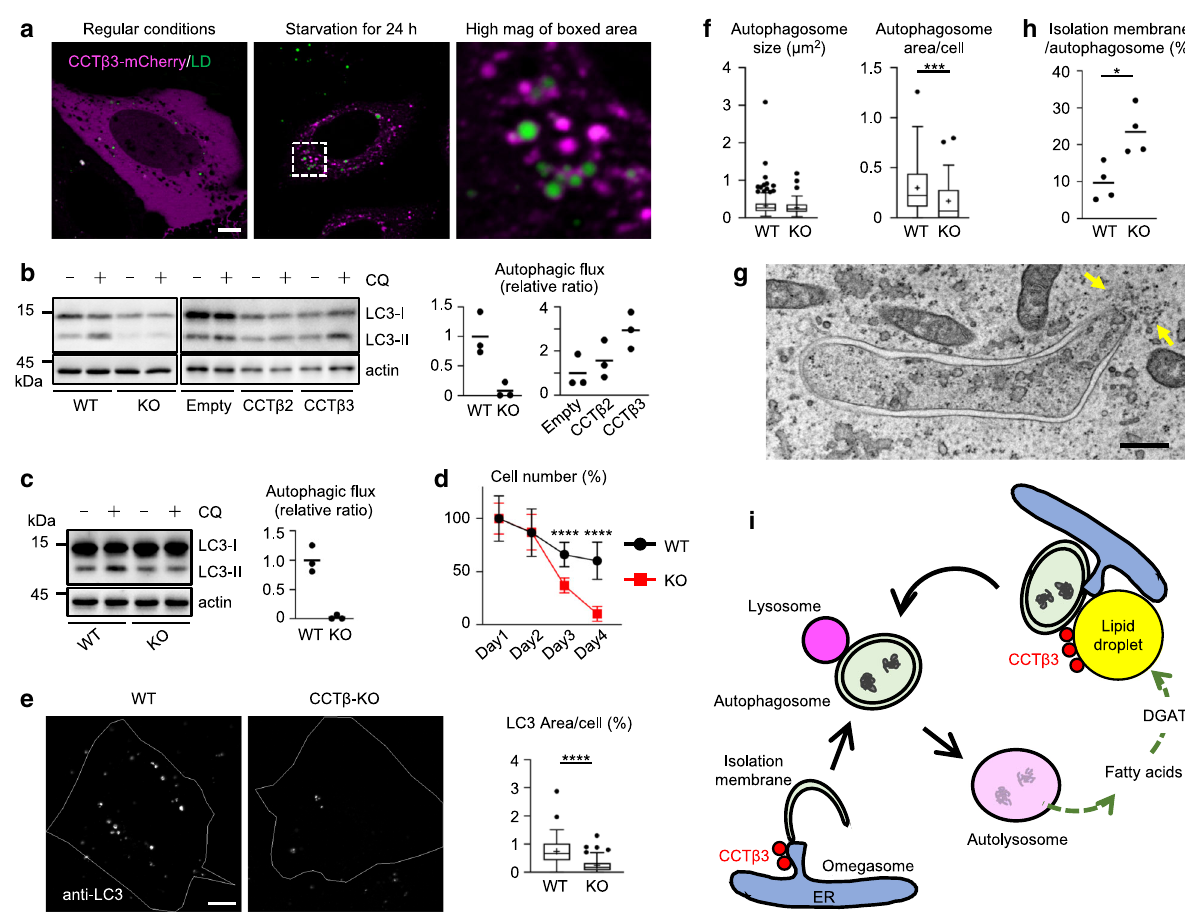
Fig. 7 CCT β 3 in U2OS. a Distribution of CCT β 3-mCherry (magenta) and LDs (green). Bar, 10 μ m. b The autophagic fl ux after starvation for 24 h. Wild- type U2OS and CCT β -null U2OS (left panel), and CCT β -null U2OS transfected with an empty vector, CCT β 2 cDNA, or CCT β 3 cDNA (right panel) were compared. A representative result of three independent experiments. c The autophagic fl ux after 2 days of hypoxia (0.1% O 2 ) in regular medium. A representative result of two independent experiments. d Cell survival in prolonged starvation. Cells were plated on day 0 and switched to starvation medium on day 1. The number of living cells on day 1 was set as 100%. Pooled data obtained in two independent experiments. Mean± s.d. of 12 samples. **** p < 0.0001 (unpaired two-tailed t -test). e Endogenous LC3 in wild-type and CCT β -null U2OS cultured for 24 h in starvation medium. Bar, 10 μ m. Pooled data obtained in three independent experiments ( n = 90); **** p < 0.0001 (two-tailed Mann – Whitney test). f Quanti fi cation of autophagosomes by EM. Wild-type and CCT β -null U2OS cultured for 24 h in starvation medium. The average autophagosome size (left) and the total area of autophagosomes in the cytoplasm (right). Pooled data from four independent experiments. *** p = 0.0010 (two-tailed Mann – Whitney test). The number of cells examined: 45 (wild-type) and 41 (CCT β -null). The number of autophagosomes examined: 249 (wild-type) and 83 (CCT β -null). g Elongated isolation membrane in CCT β - null U2OS starved for 24h. Bar, 0.2 μ m. IMAT membranes (arrows). See Supplementary Fig. 7G for additional micrographs. h The numerical ratio of isolation membranes to autophagosomes measured by EM. Wild-type and CCT β -null U2OS cultured for 24 h in starvation medium. Four independent experiments. * p = 0.0286 (two-tailed Mann – Whitney test). The number of isolation membranes observed: 24 (wild-type) and 21 (CCT β -null). i CCT β 3 in autophagy. In cells starved for a short time, CCT β 3 is activated near autophagic membranes. After prolonged starvation, CCT β 3 is recruited to LDs generated from autophagic digests, and the resultant activation of PC synthesis facilitates autophagic membrane formation near LDs, thereby sustaining autophagy. In box plots, the center line indicates the median, box boundaries indicate the 25th and 75th percentiles, whiskers are Tukey-type, and the average is marked as + . Source data are provided as a Source data fi Methods medium at a fi nal concentration of 0.4mM 60 . Hypoxic conditions were produced Cell culture and reagents . MEFs without or with the expression of GFP-ULK1, using the BIONIX-3 hypoxic culture kit (Sugiyama-gen). T863 (SML0539-5MG, Sigma), avasimibe (A794680, Toronto Research Chemicals), and Atglistatin (15284, GFP-WIPI1, GFP-DFCP1, or GFP-LC3 20 were kindly provided by Dr. Noboru Cayman Chemical) were used for the inhibition of DGAT1, ACAT, and ATGL, Mizushima (University of Tokyo). U2OS and Huh7 cells were kindly donated by respectively. Dr. Hidemasa Goto (Mie University) and Dr. Eija Jokitalo (University of Helsinki), respectively. MEFs and U2OS were cultured in Dulbecco ’ s modi fi ed Eagle medium supplemented with 10% FBS and antibiotics. For Huh7, Eagle ’ s minimum essential medium supplemented with 10% FBS and antibiotics were used. The cells were maintained at 37°C in a humidi fi ed atmosphere of 95% air and 5% CO 2 . The total choline concentration in the medium was measured using LabAssay TM Phopho- lipid (296-63801, Fuji fi lm Wako Pure Chemical). Autophagy was induced by culturing cells in a serum-free EBSS (6.8 mg ml – 1 NaCl, 0.4 mgml – 1 KCl, 0.16 mg ml – 1 NaH 2 PO 4 (cid:129) 2H 2 O, 0.26mg ml – 1 CaCl 2 (cid:129) 2H 2 O, 0.21mg ml – 1 MgSO 4 (cid:129) 7H 2 O, 2.2 mg ml – 1 NaHCO 3 , 1mg ml – 1 glucose). OA was conjugated with fatty acid-free BSA (Fuji fi lm Wako Pure Chemical) at a 6:1 molar ratio before being added to the